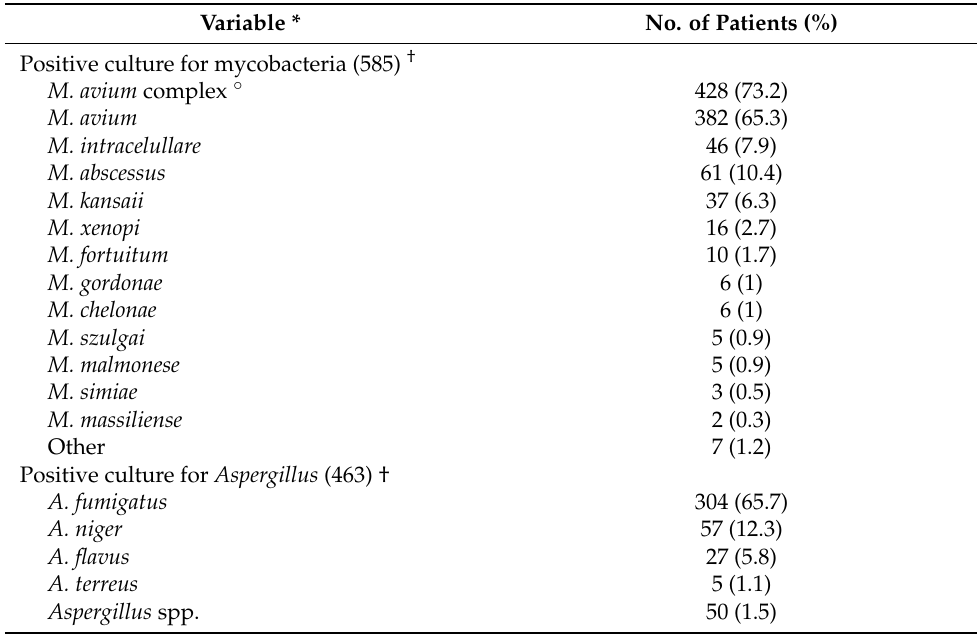
Table 3. Diagnostic Procedures and Microbiologic